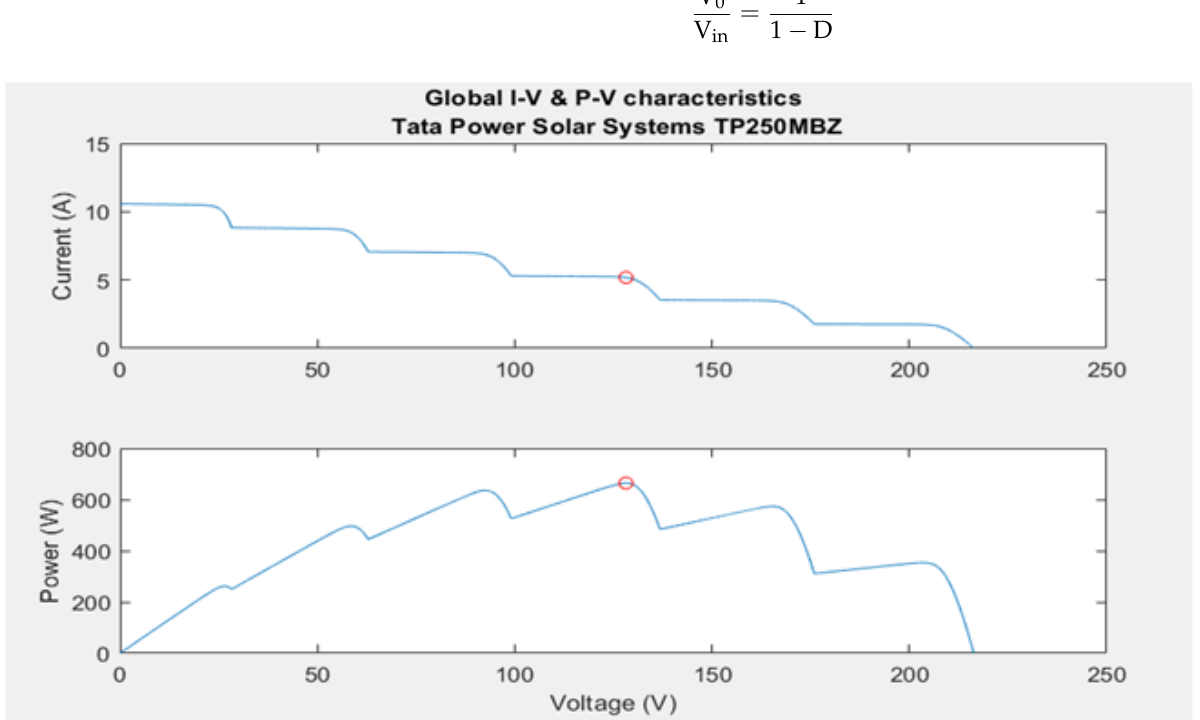
Figure 4. Current – voltage and power – voltage graphics for the second complex shading condition. Figure 4. Current–voltage and power–voltage graphics for the second complex shading condition.